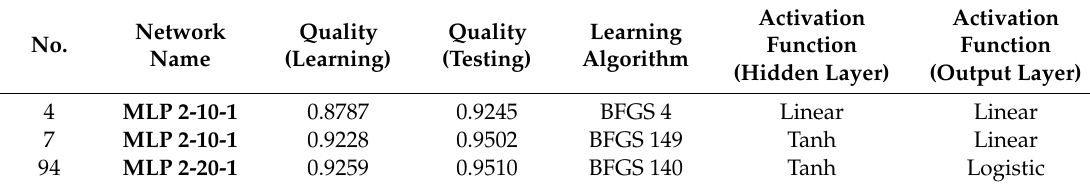
Table 4. Selected neural networks based on the cutting force components (generated in Statistica).